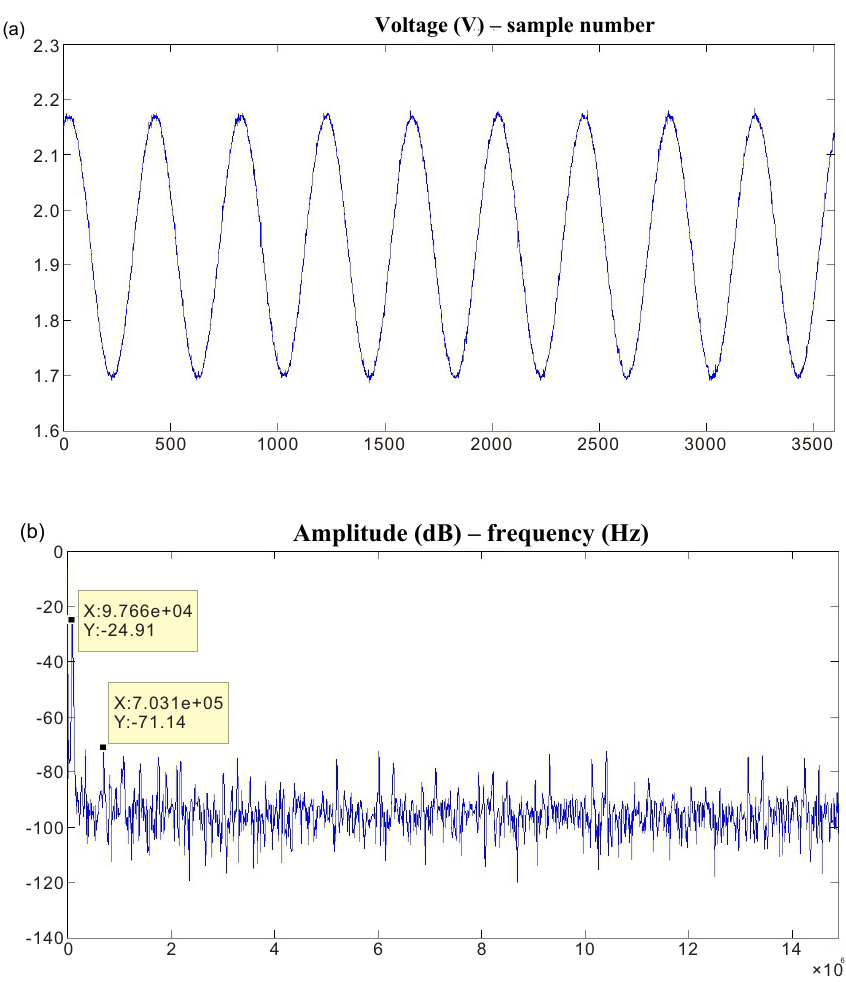
Figure 9. Test results of the high-speed voltage acquisition channel. (a) Time domain waveform of the 20Vpp, 100kHz sinusoid acquired by the high-speed voltage recording device at a 100V level. (b) Amplitude-frequency characteristics of the 4906 samples subjected to FFT (Hanning window